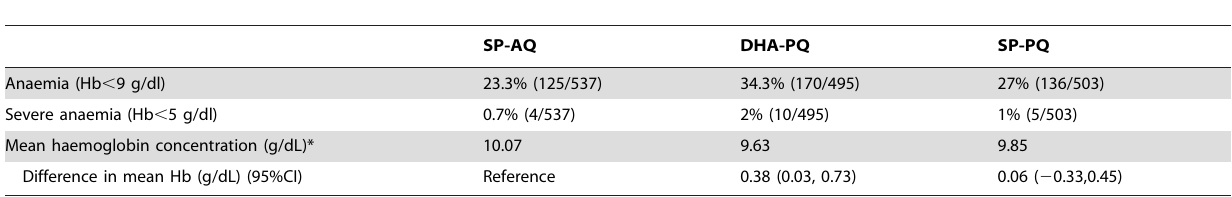
Table 6. Prevalence of anaemia and mean haemoglobin concentration at the end of the malaria transmission